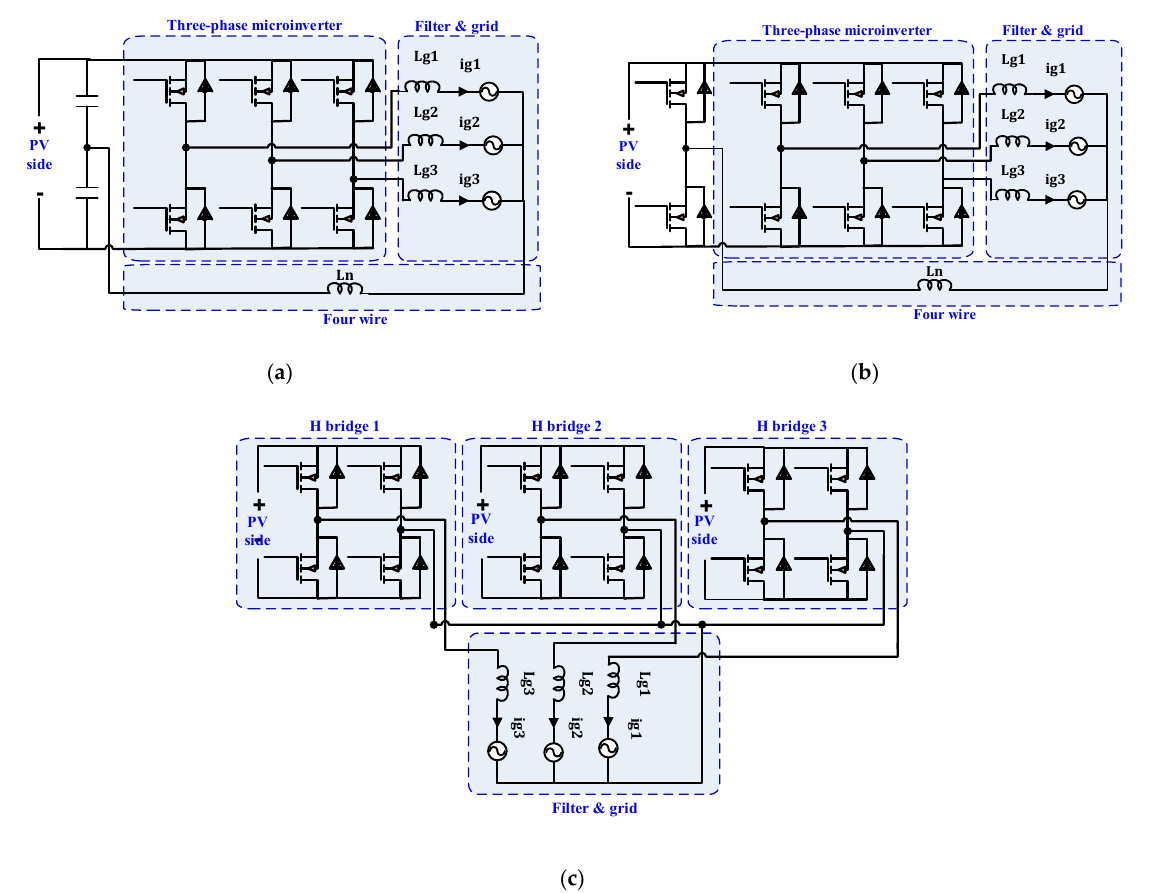
Figure 4. Different ways to supplement four-wire at three-phase microinverters: ( a ) split capacitor four-wire microinverter; ( b ) four-leg four-wire microinverter; ( c ) added four-wire for three independent phases.